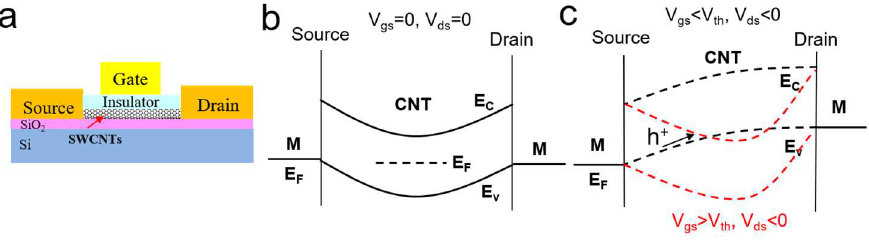
Figure 5. Schematic representation of the device structure of CNTFET. ( a ) The three-electrode configuration in a CNTFET. ( b , c ) Device energy band diagram.